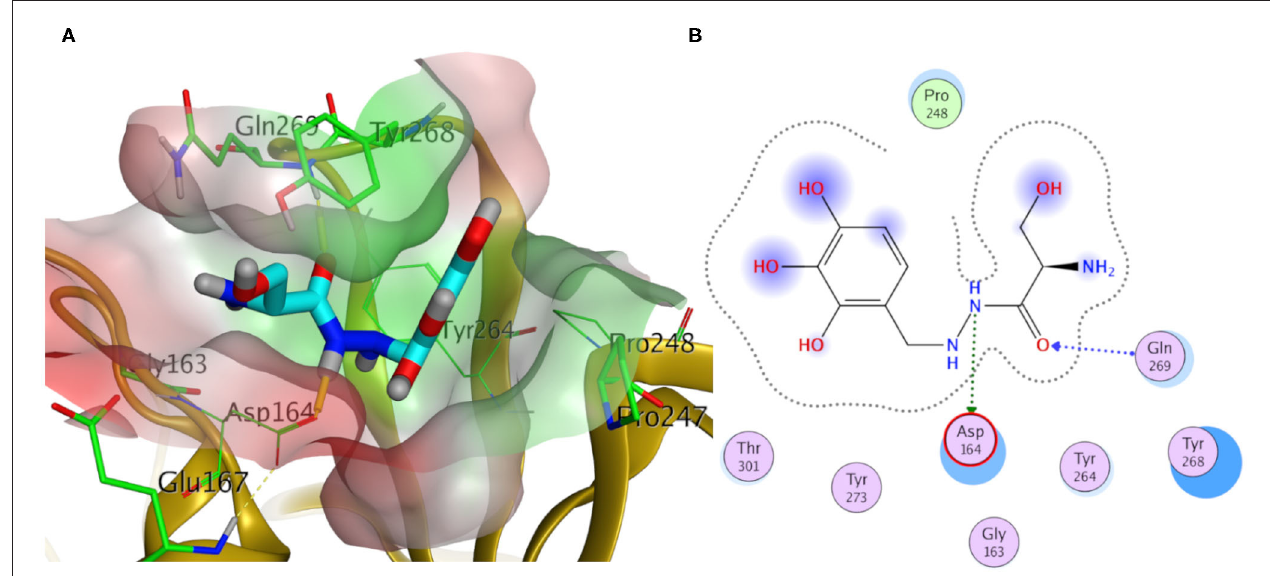
FIGURE 10 | Docking pose of benserazide as cyan sticks in the binding site of SARS-CoV-2 PLpro (PDB ID: 7JRN) in three- and two- dimensional depictions for (A,B) , respectively. Polar and non-polar regions of the binding site were presented by red- and green-colored molecular surfaces, respectively. Dashed lines indicate favorable interactions. Non-polar hydrogen atoms were omitted for